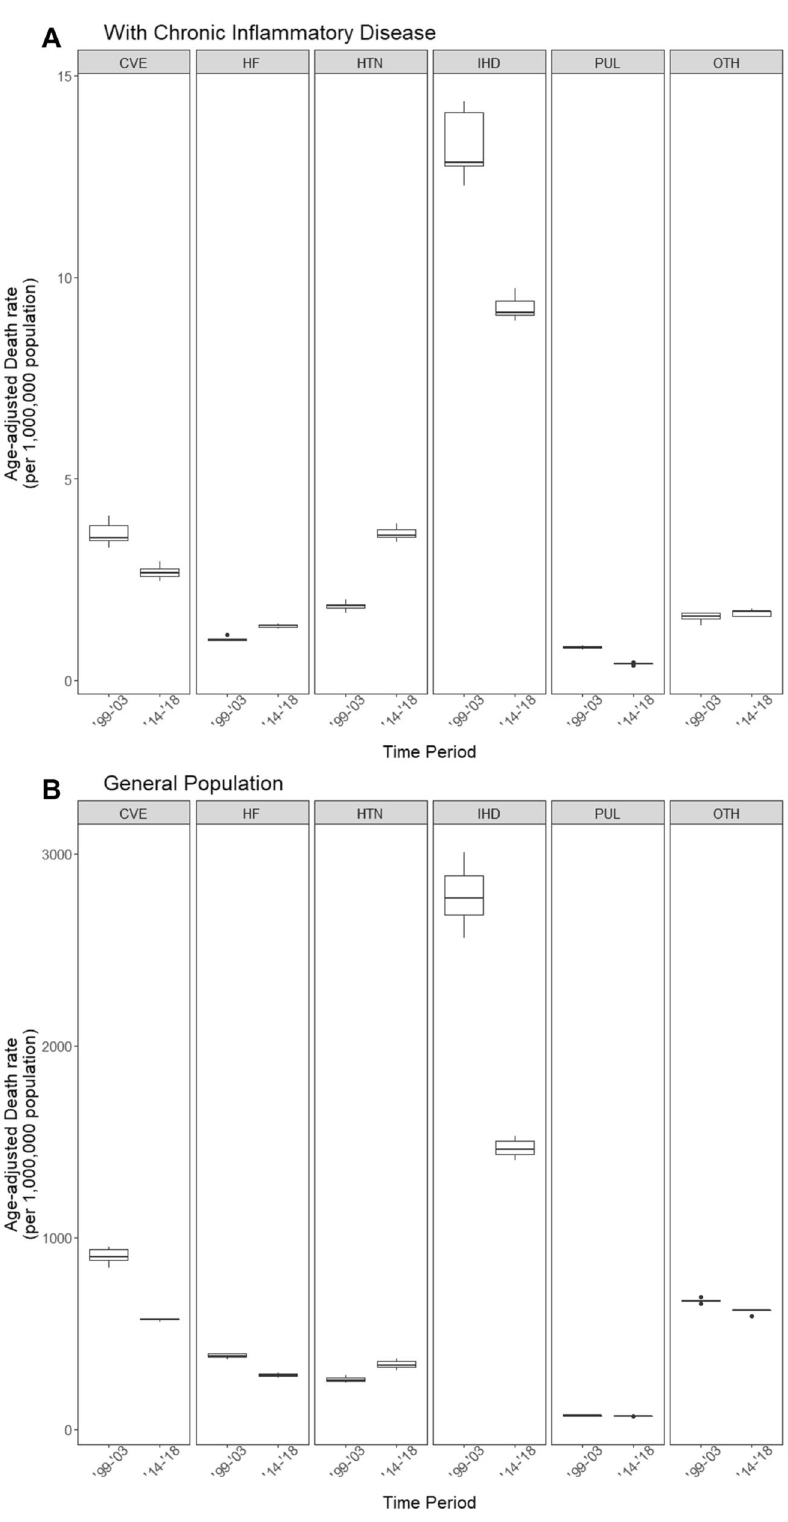
Figure 2. Age-adjusted cardiovascular death rate by cause for patients with chronic infectious or inflammatory disease in 1999–2003 vs 2014–2018. CVE Cerebrovascular events, HF Heart failure, HTN Hypertensive diseases, IHD Ischemic heart disease, OTH Other causes of cardiovascular disease, PUL Pulmonary heart